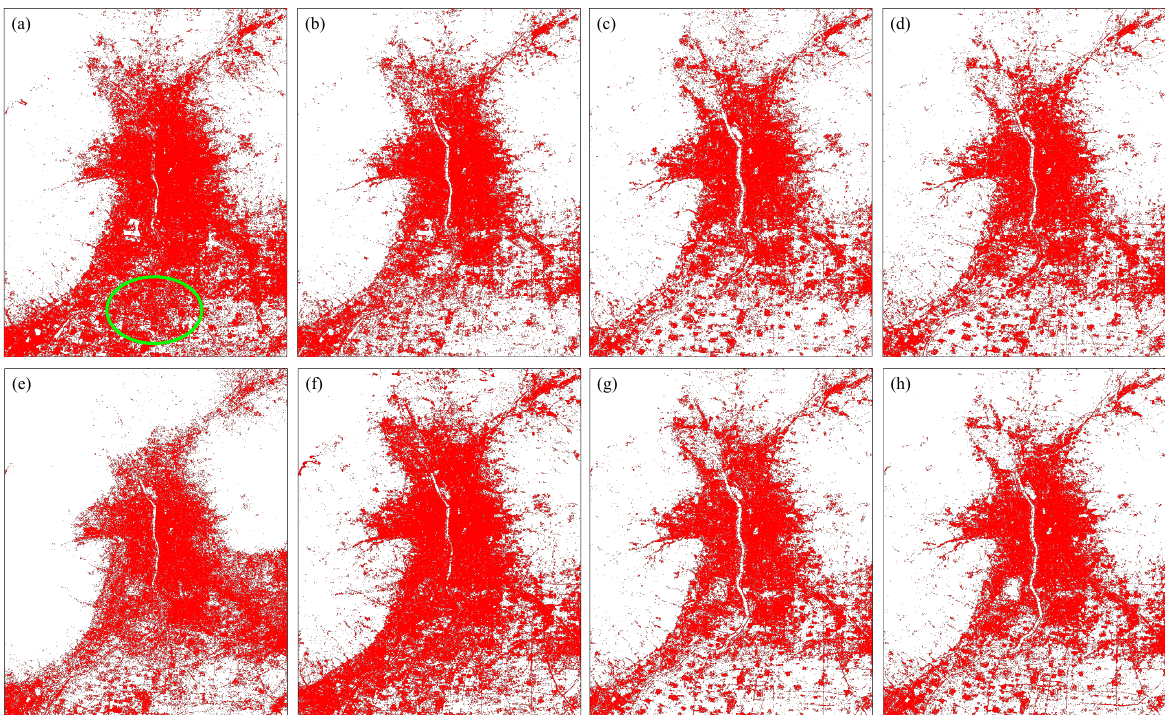
Figure 3. Extracted IS data of Taiyuan City, Shanxi Province, in 2018, (a) for January, (b) for March, (c) for June, (d) for September, and in 2019, (e) for January, (f) for March, (g) for June, (h) for September. parameter of the classification tree is determined as shown in Figure. 2.